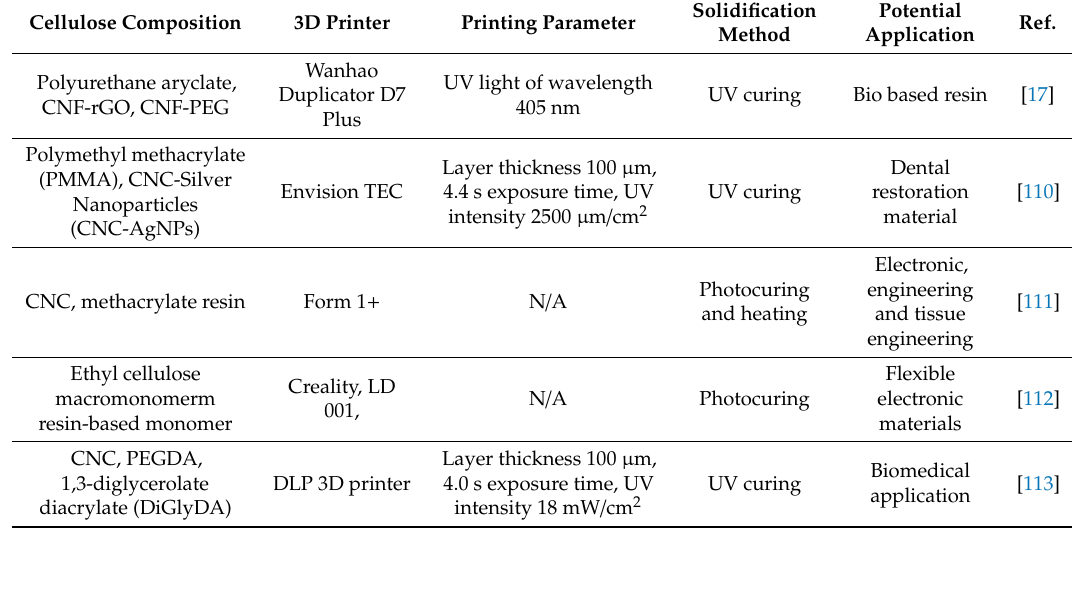
Table 4. The compatibility of cellulose-based biopolymer as a filler in photopolymeric resins.